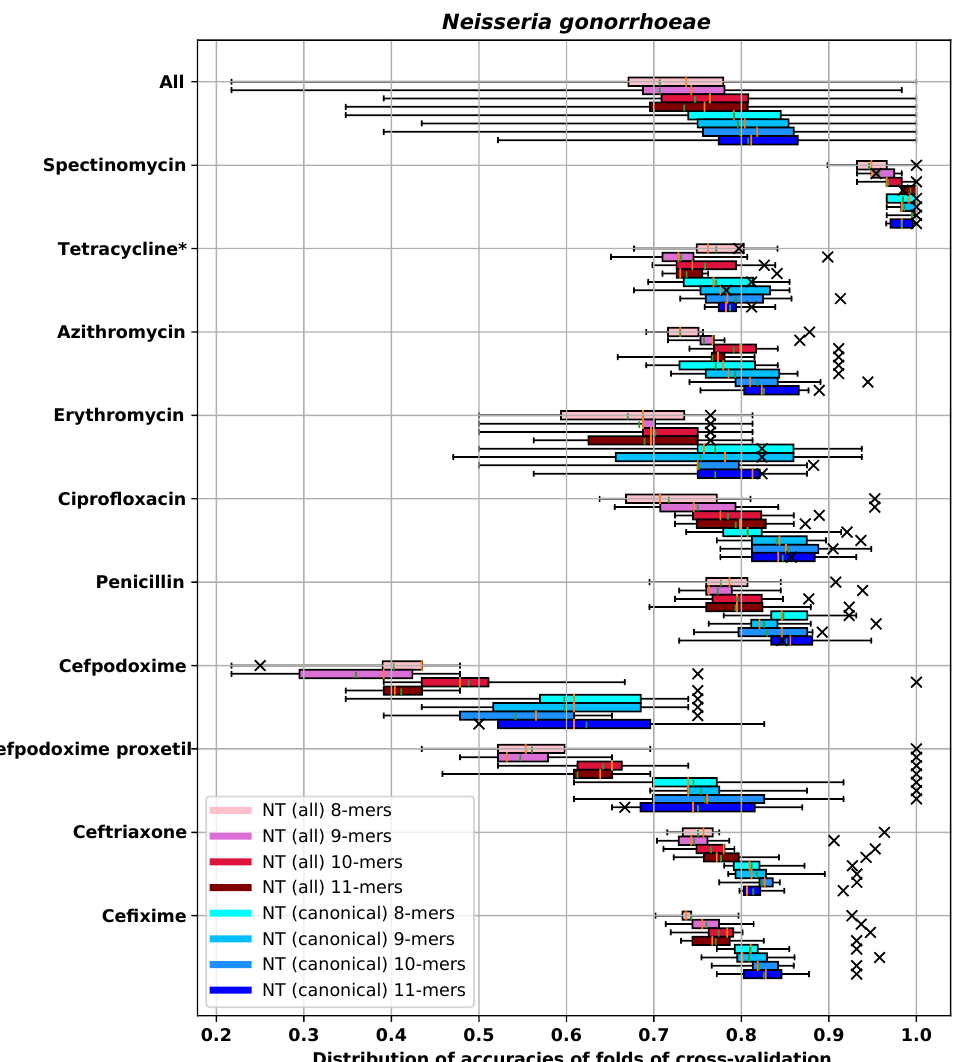
Figure A9. Distribution of accuracies in different nucleotide k -mers for N. gonorrhoeae . Plots are similar to Figure